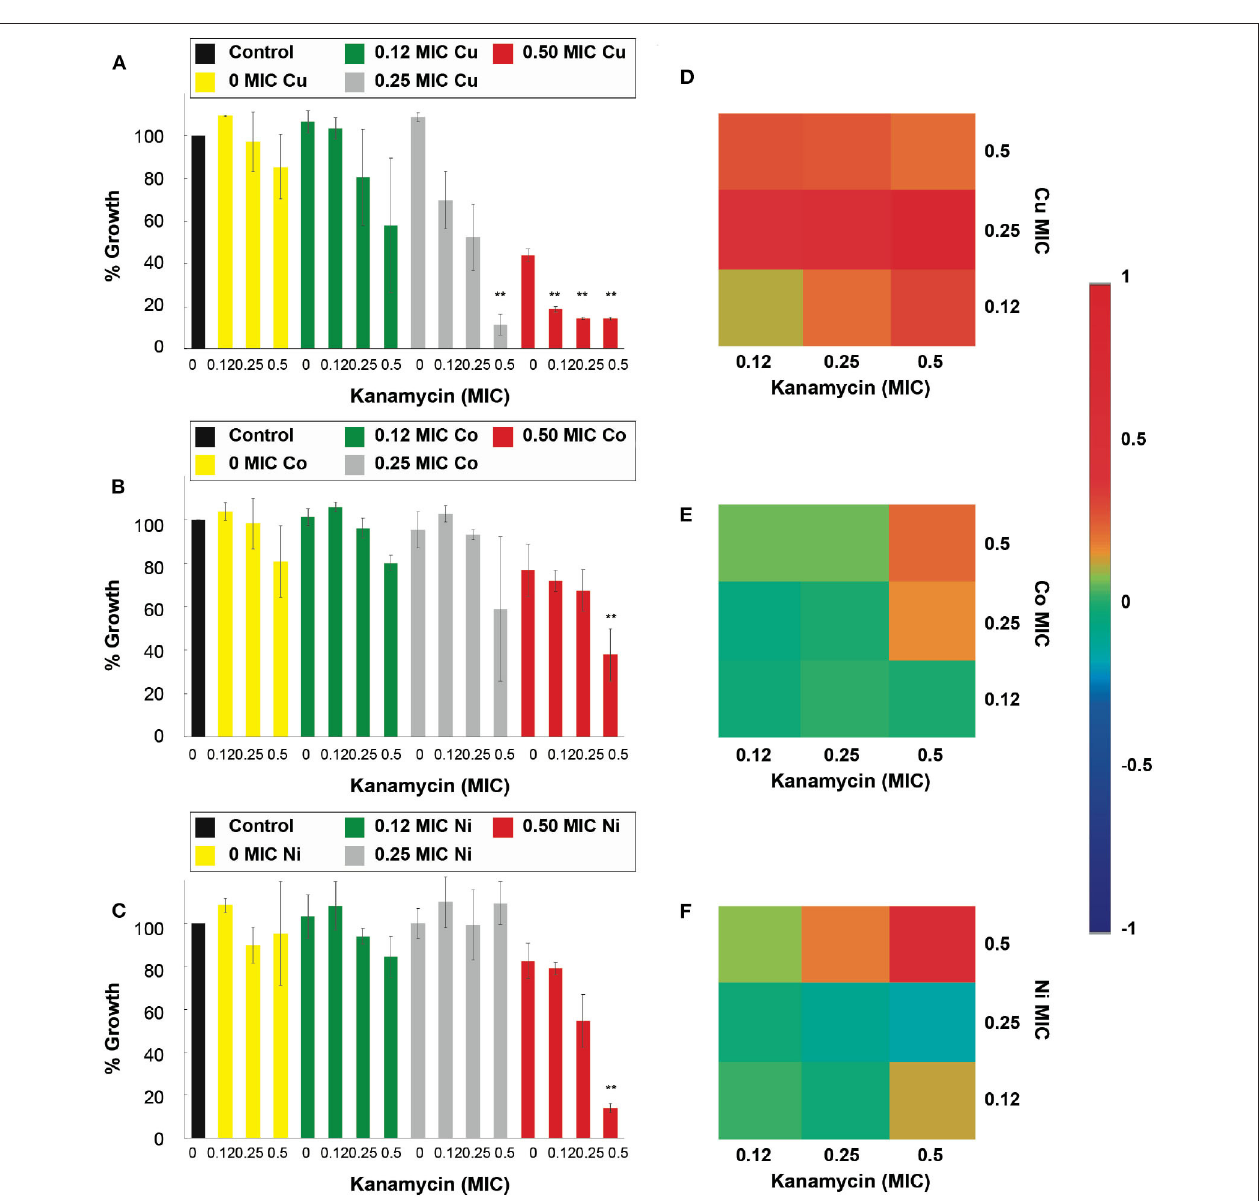
FIGURE 5 | Antimicrobial effect and interactions of ATMCs in S. aureus . Growth percentage by sub-inhibitory concentrations of metal ion-antibiotic combinations: (A) Cu 2 + -kanamycin, (B) Co 2 + -kanamycin, and (C) Ni 2 + kanamycin against S. aureus ATCC 6538. Classification of the different interactions between metal ion-antibiotic combinations. The interactions of (D) Cu 2 + -kanamycin, (E) Co 2 + -kanamycin, and (F) Ni 2 + -kanamycin combinations are classified as synergistic, additive or antagonist, value > 0, = 0, and < 0, respectively. Each experiment was done in triplicates. **Corresponds to a significant difference ( p < 0.05) concerning the control and each of the individual treatments. Error bars correspond to the standard deviation from experiments performed in triplicates.